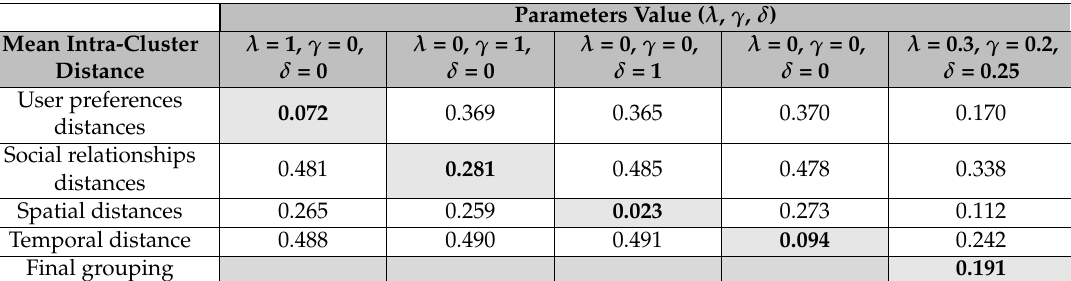
Table 3. The mean intra-cluster distances of user preference, spatial proximity, social relationships, and free days for database #1.